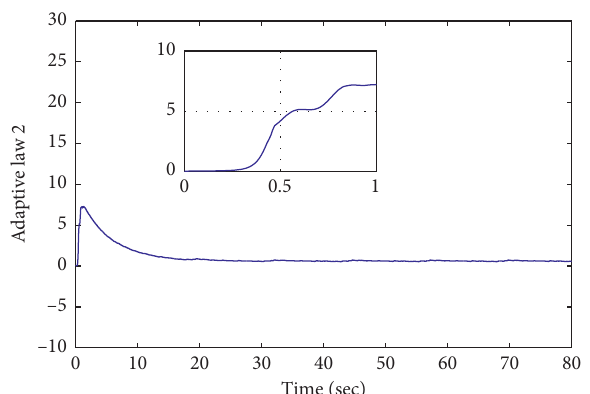
Figure 4: The trajectory of the adaptive law